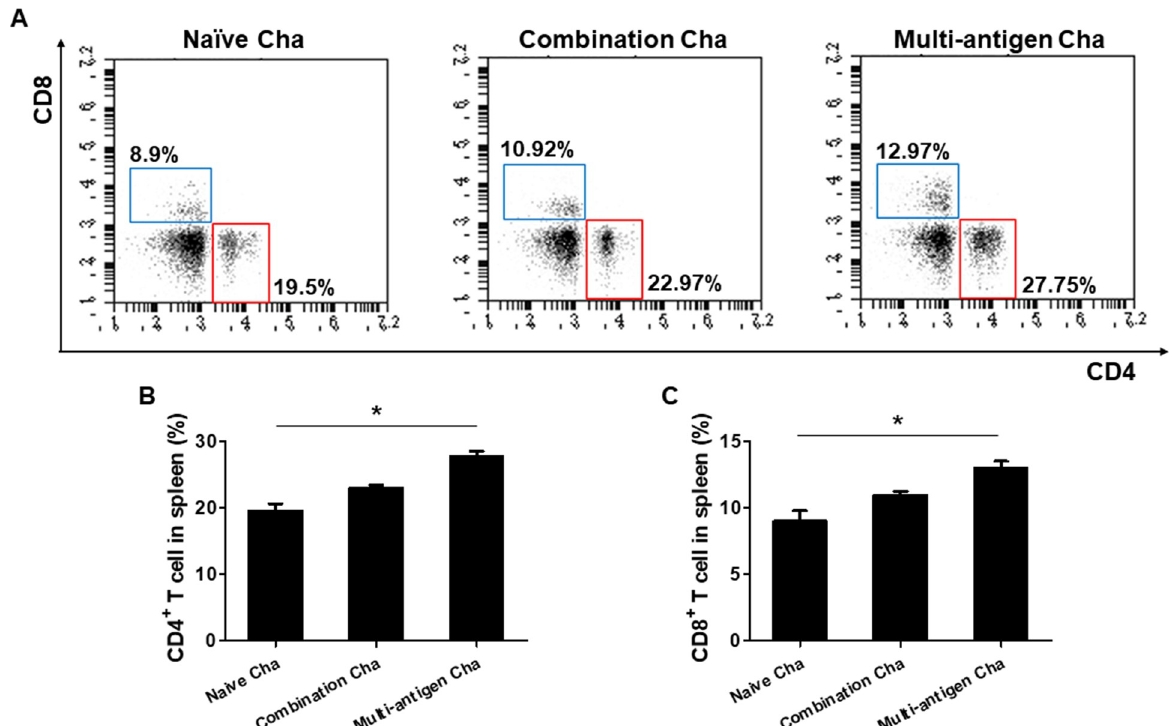
Fig 3. CD4 + and CD8 + T cell response. To investigate the T cell responses, the splenocytes were prepared from mice spleen and stained with fluorescence conjugated CD3, CD4 and CD8 antibodies (A). The highest levels of CD3 + , CD4 + (B) and CD3 + , CD8 + (C) T cells were found in multi-antigen VLPs immunized mice (Multi-antigen Cha) compared to combination VLPs immunized mice or na ï ve challenged mice ( � P < 0.01).